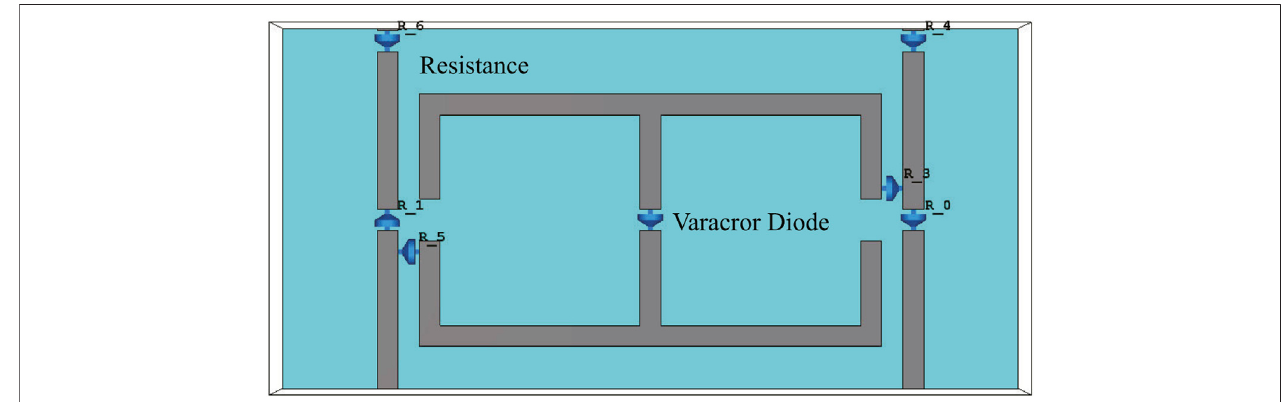
FIGURE 1 | The tunable unit of recon fi gurable